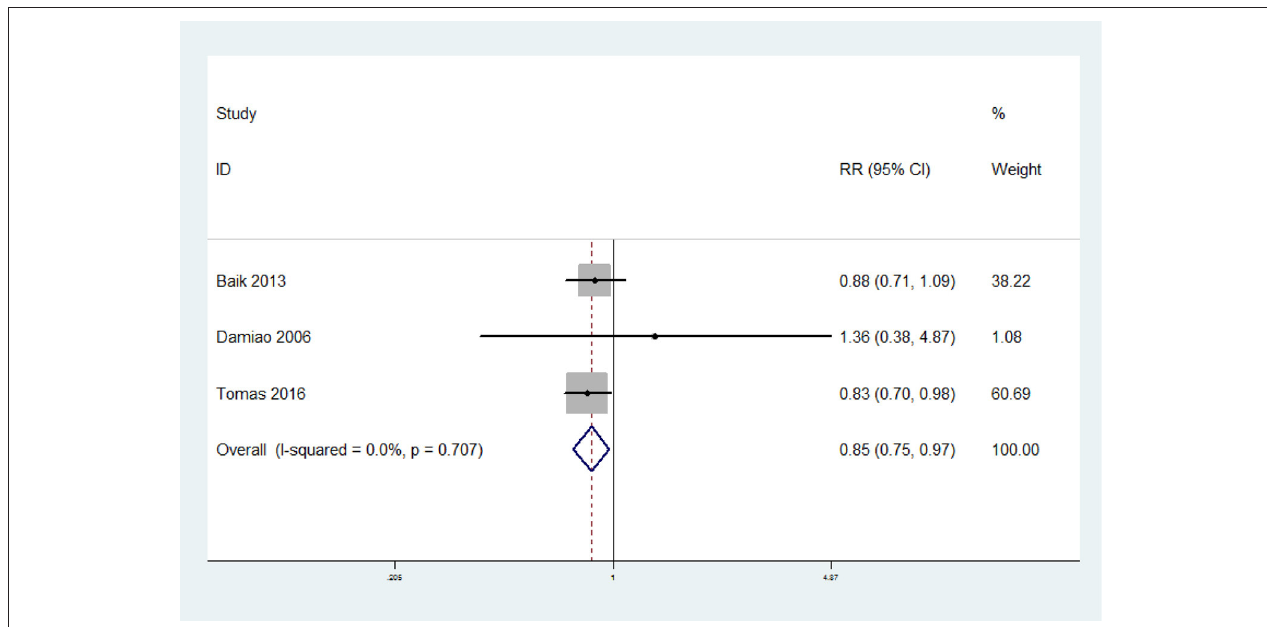
FIGURE 5 | Forest plot of meta-analysis: overall multi-variable adjusted RR of MetS for the highest vs. lowest category of poultry consumption.